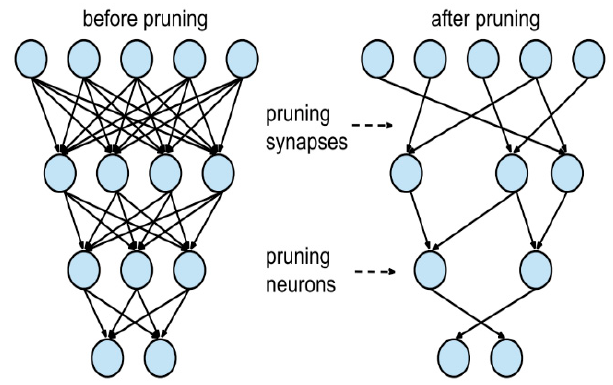
Figure 8. Figure 8. Pruning.